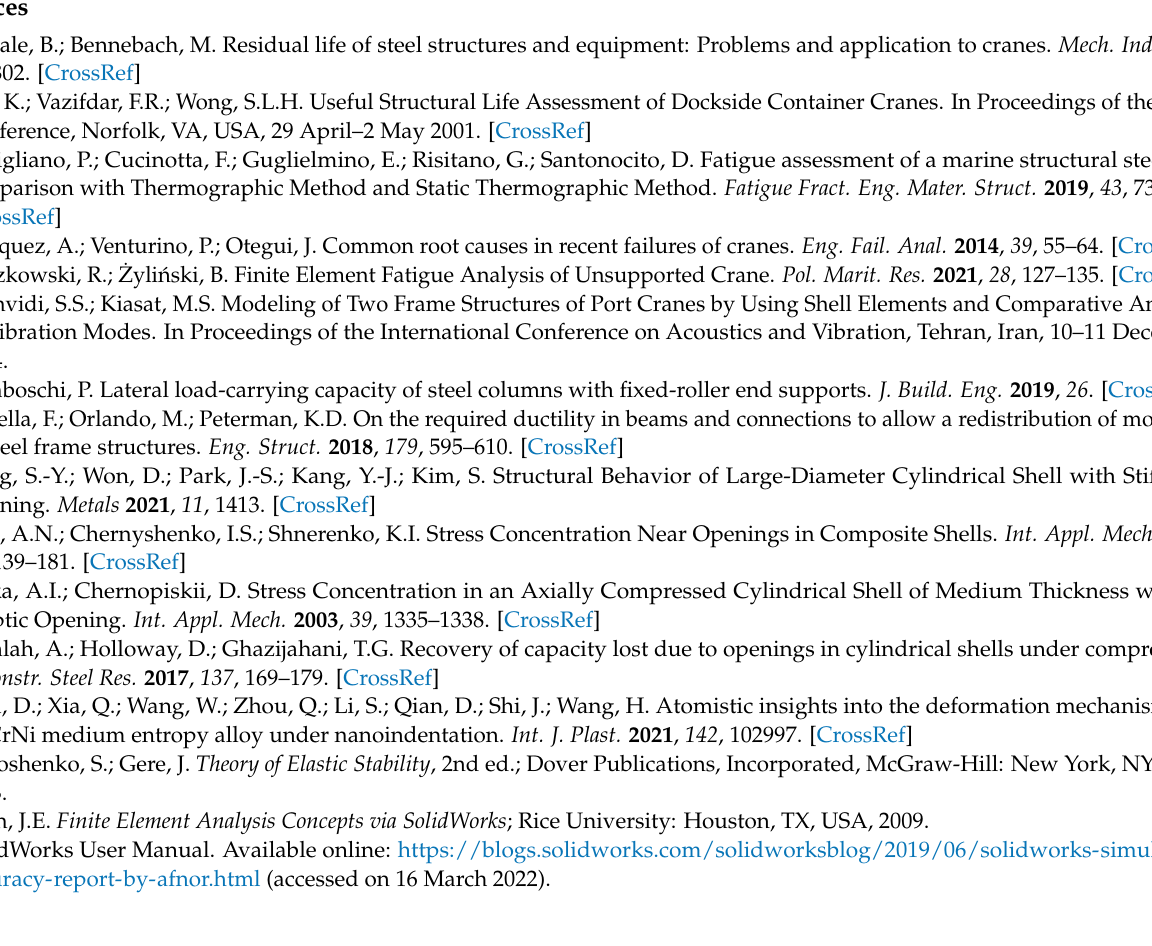
Quadrilateral mechanism-closing elements, Figure S4. Counterweight, Figure S5. Main boom (arm) section, Figure S6. a–c Transducer-positioning scheme, Figure S7. Graphic approach, Figure S8. Analytical approach, Figure S9. Initial variant cross section, Figure S10. Plated variant cross section, Figure S11. Equivalent normal stress—von Mises criterion, Figure S12. Deformation field, Figure S13. Main boom (arm) meshing, Figure A14. Buckling